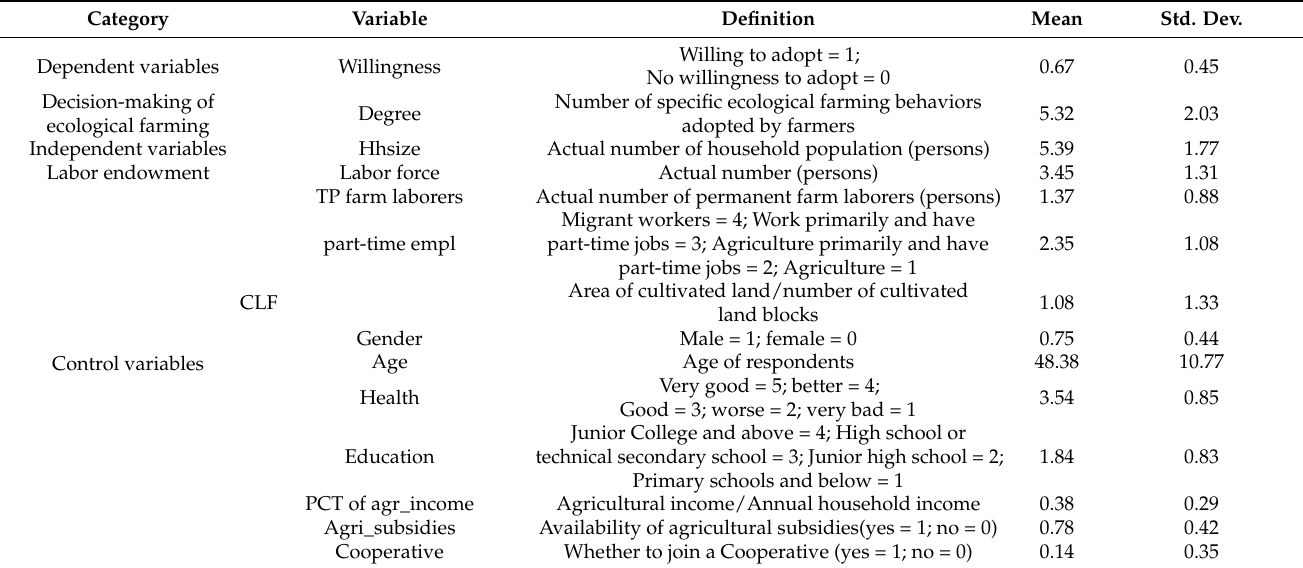
Table 1. List of variables and descriptive